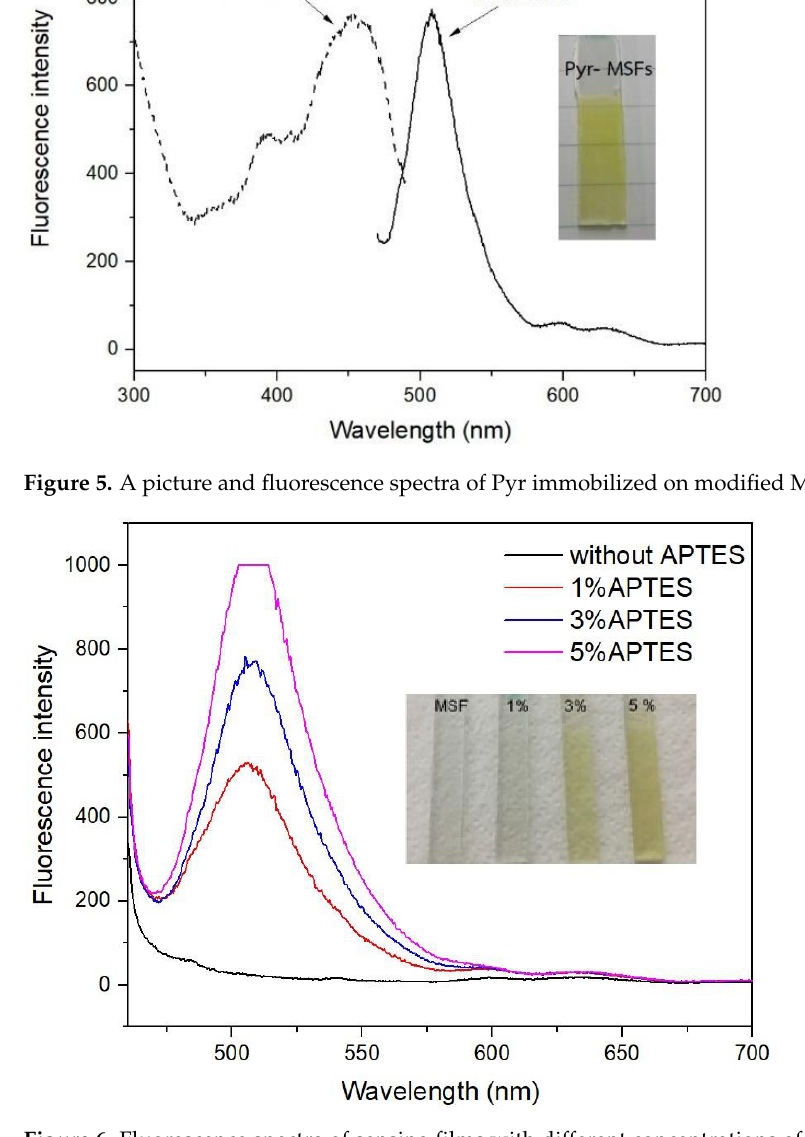
Figure 6. Fluorescence spectra of sensing films with different concentrations of APTES at pH